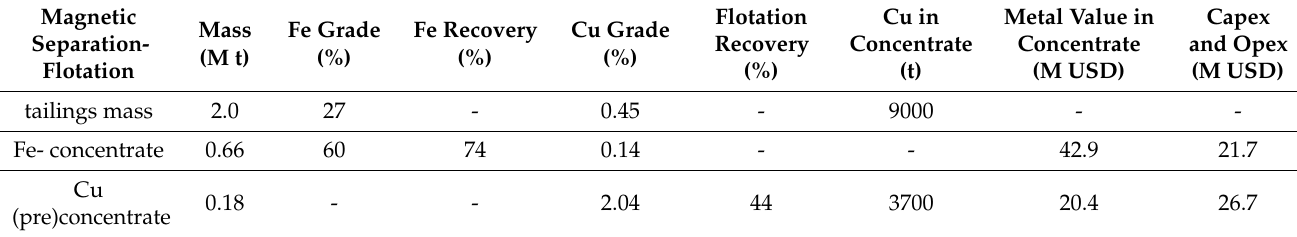
Table 10. Data of coarse-grained tailings material and (pre)concentrates of copper and iron, including recoveries, metal value and investment, processing, and transport costs for the scheme of first magnetic separation and second flotation.